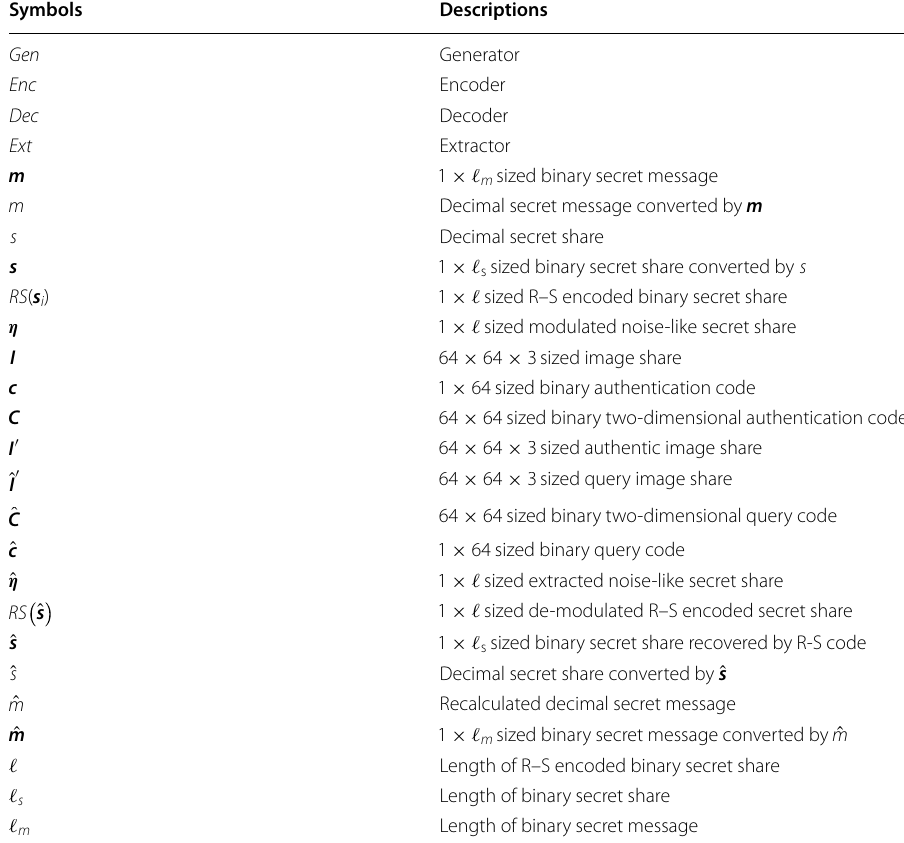
Table 1 Descriptions of the main notations used in the proposed scheme